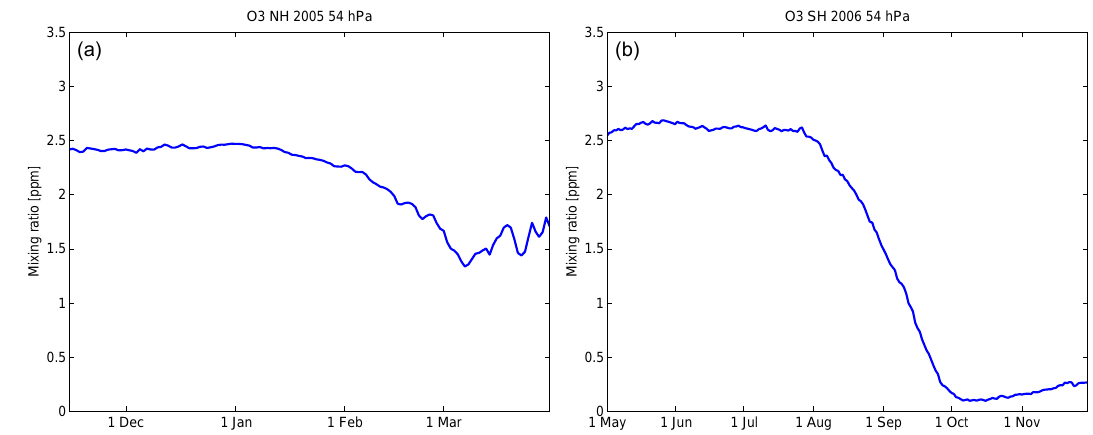
Figure 19. Vortex-averaged ozone mixing ratios for the Arctic winter 2004–2005 (a) and the Antarctic winter 2006 (b) at 54hPa.